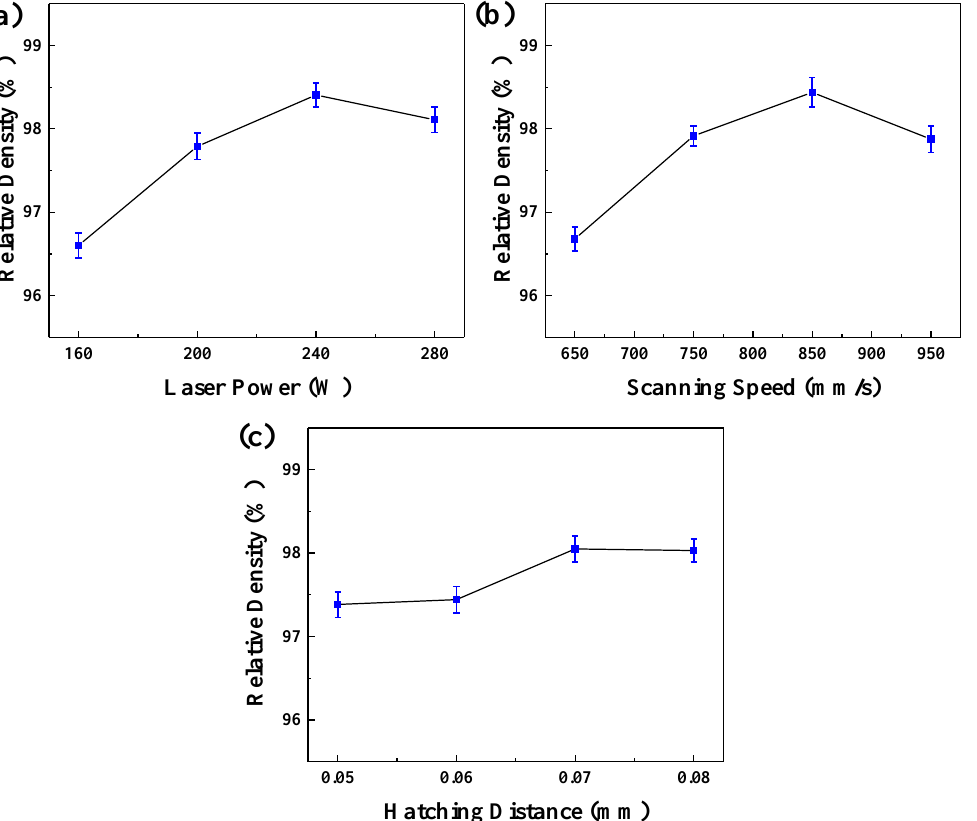
Figure 5. The influence of process parameters on the relative density of samples: ( a ) Laser Power, ( b ) Scanning Speed, ( c ) Hatching Distance.